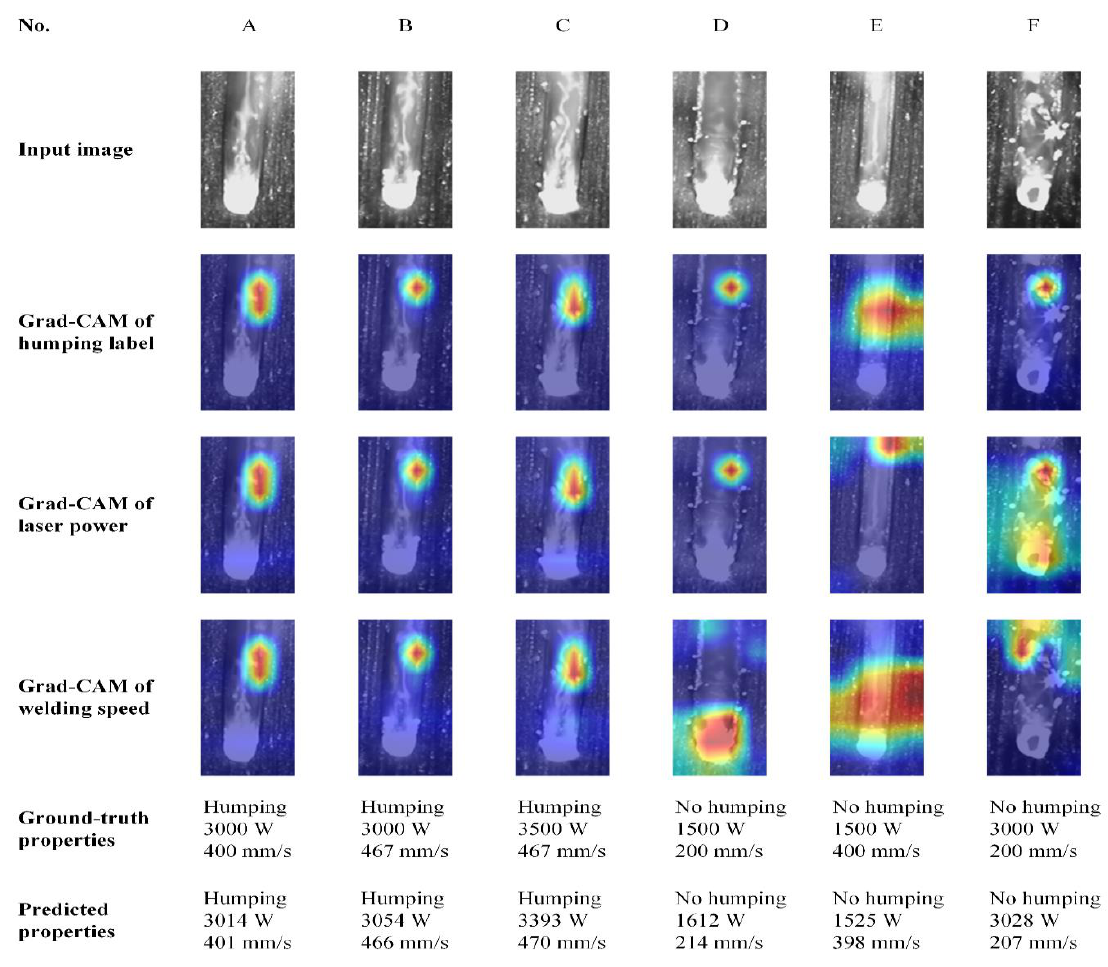
Figure 12. Examples of Grad-CAMs of samples with different welding state.